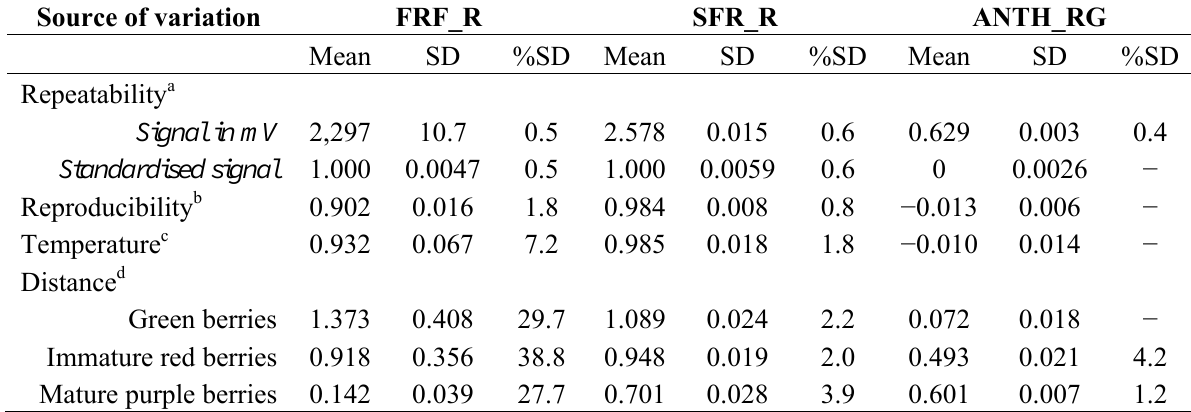
Table 2. Sources of measurement variability. Mean, standard deviation (SD) and percent standard deviation (%SD) are given for the major signal used (FRF_R, cf. Table 1) and for the Multiplex ® indices for anthocyanins (ANTH_RG) and chlorophyll (SFR_R). Source of